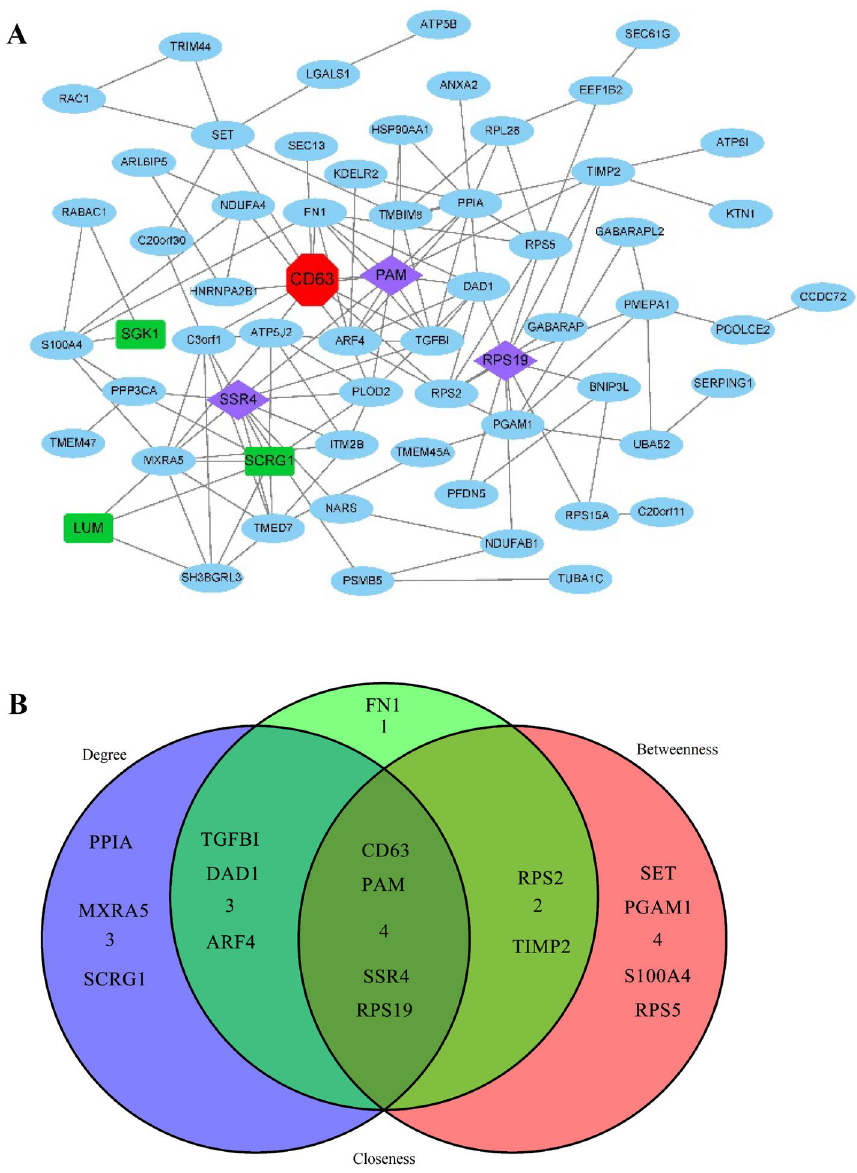
Figure 3. Gene co-expression network and topological features. ( A ) A total of 81 gene nodes and 43 interaction pairs obtained in the Weighted Correlation Network Analysis with the threshold of Cor > 0.6. ( B ) Intersection of the top 10 genes in each Topological Features (Betweenness, Closeness and Degree) related to intervertebral disc